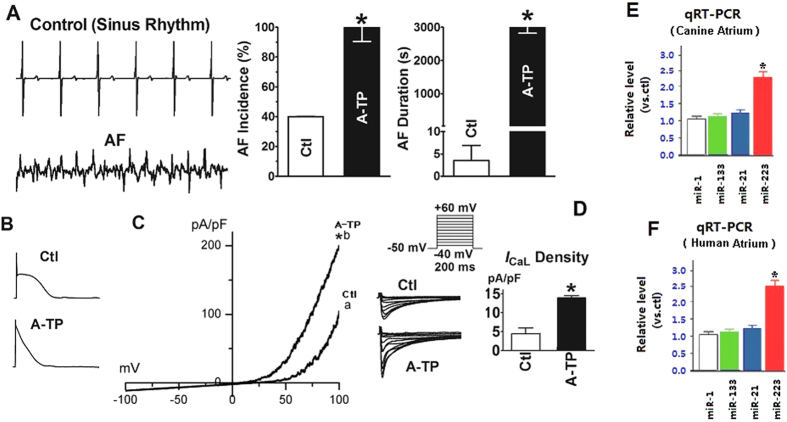
Characterization of the canine AF model.AF was induced by A-TP for 8 weeks. AF was induced by a single premature extrastimuli at a basic pacing cycle length of 300 msec. (A) Verification of AF vulnerability. Left, representative direct atrial activation recordings obtained from the left atrial wall of a control (Ctl) dog with sinus rhythm, and an A-TP dog (AF). Right, averaged data of AF incidence and duration. AF incidence was the number of animals demonstrating at least one run of induced AF, and AF duration was measured once induced. *P < 0.05 vs Ctl, unpaired t test; n = 5 dogs in each group. (B,C) Verification of atrial electrical remodeling. Note that ICa, L is significantly upregulated in A-TP dogs. *P < 0.01 vs Ctl. (D) Enhancement of ICa, L density (ICa, L, pA/pF) in A-TP animals relative to Ctl. Action potentials were recorded in single, freshly isolated atrial myocytes using the current-clamp mode in the whole-cell patch-clamp configuration. ICa, L was recorded using the voltage-clamp mode in the whole-cell patch-clamp configuration; the voltage protocols are shown in the inset. *P < 0.05 vs Ctl, unpaired t test; n = 20 cells in each group. (E) qRT-PCR verification of upregulated miRNA-223 expression in A-TP dogs, using miR-1 as a negative control. *P < 0.001 vs. Ctl. The negative controls, miR-21 and miR-133, were unaltered in A-TP dogs. (F) qRT-PCR verification of upregulated miRNA-223 expression in AF patients, using miR-1 as a negative control. *P < 0.001 vs. Ctl. The negative controls, miR-21 and miR-133, were unaltered in AF patients.